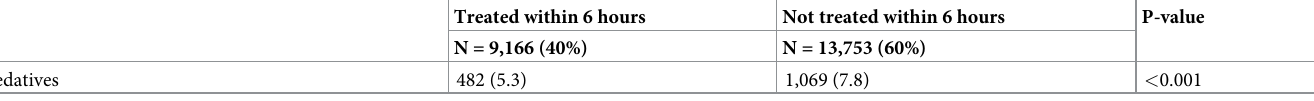
Crystalloids: ringers drip, ringers bolus, saline drip, saline